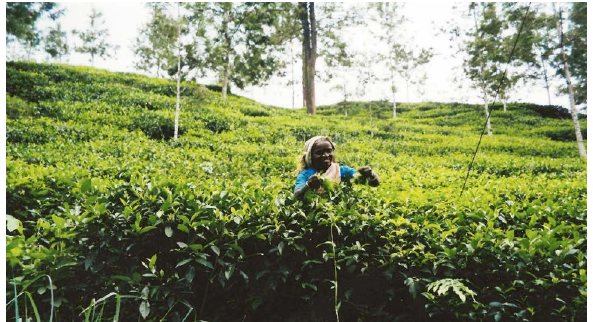
Figure 3: Tea harvesting in Sri Lanka (Photo: M. Concentrations of fluoride in soft drinks, e.g. nec- tars, juices, juice drinks, ranged between 0.10–2.0 mg/l in Portugal, 191 0.07–1.14 mg/l in the Canary Islands, 192 0.02– 2.80 mg/l in the US 193 and 0.07–1.42 mg/l in Mexico. 194 Concentrations of fluoride in juices and juices-flavoured drinks for infants and children ranged between 0.01–0.25